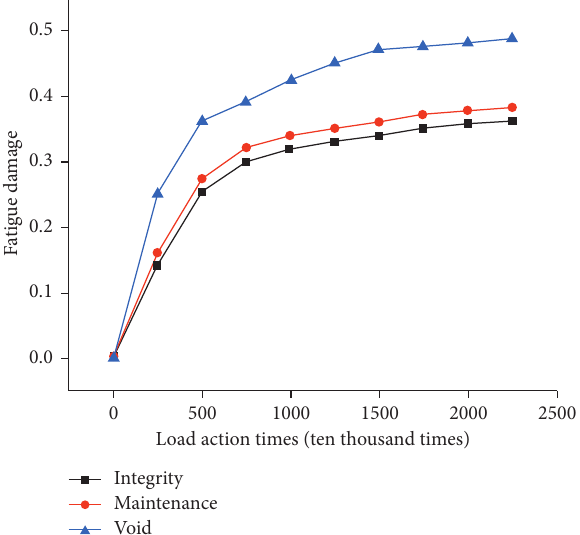
Figure 21: Cumulative evolution of fatigue damage under three working conditions under 1.0MPa tire pressure.